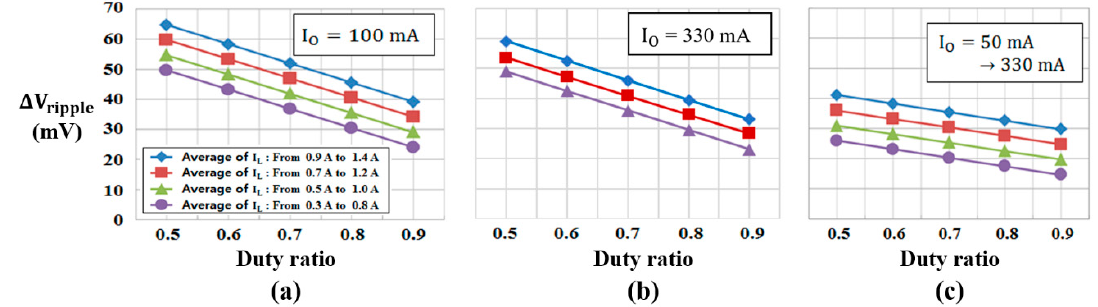
Figure 9. Simulated waveforms of the increase in output ripple voltage in terms of D A when the average inductor current level rises. The simulation is performed based on Equation (A5). The load current is ( a ) 100 mA, ( b ) 330 mA, and ( c ) increased from 50 to 330 mA.